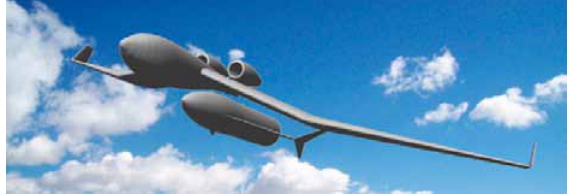
Fig. 1. The Concept of the MAS